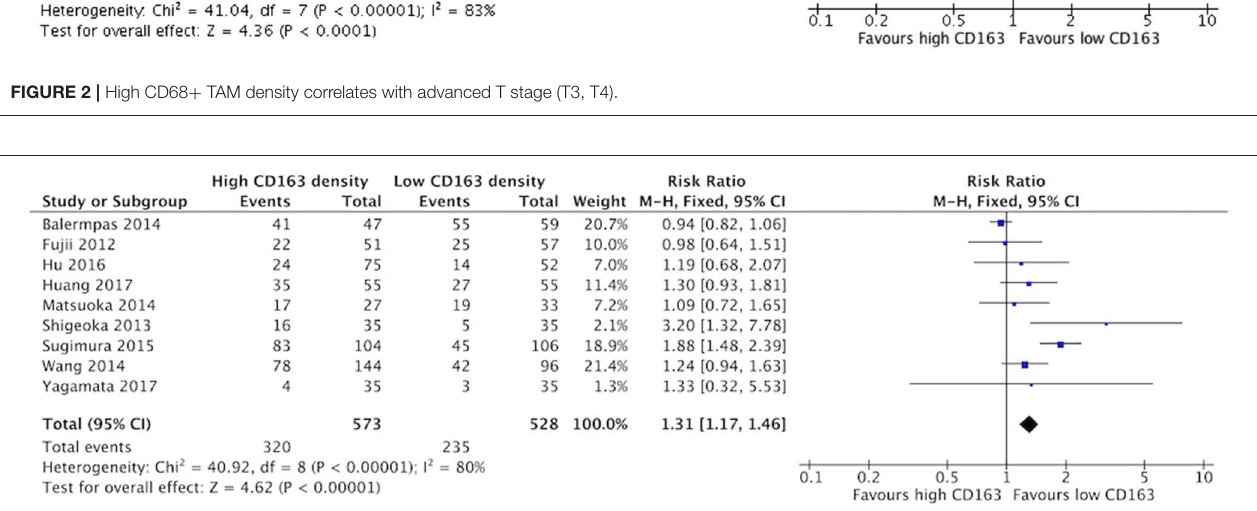
FIGURE 3 | High CD163 + TAM density correlates with advanced T stage (T3, T4).